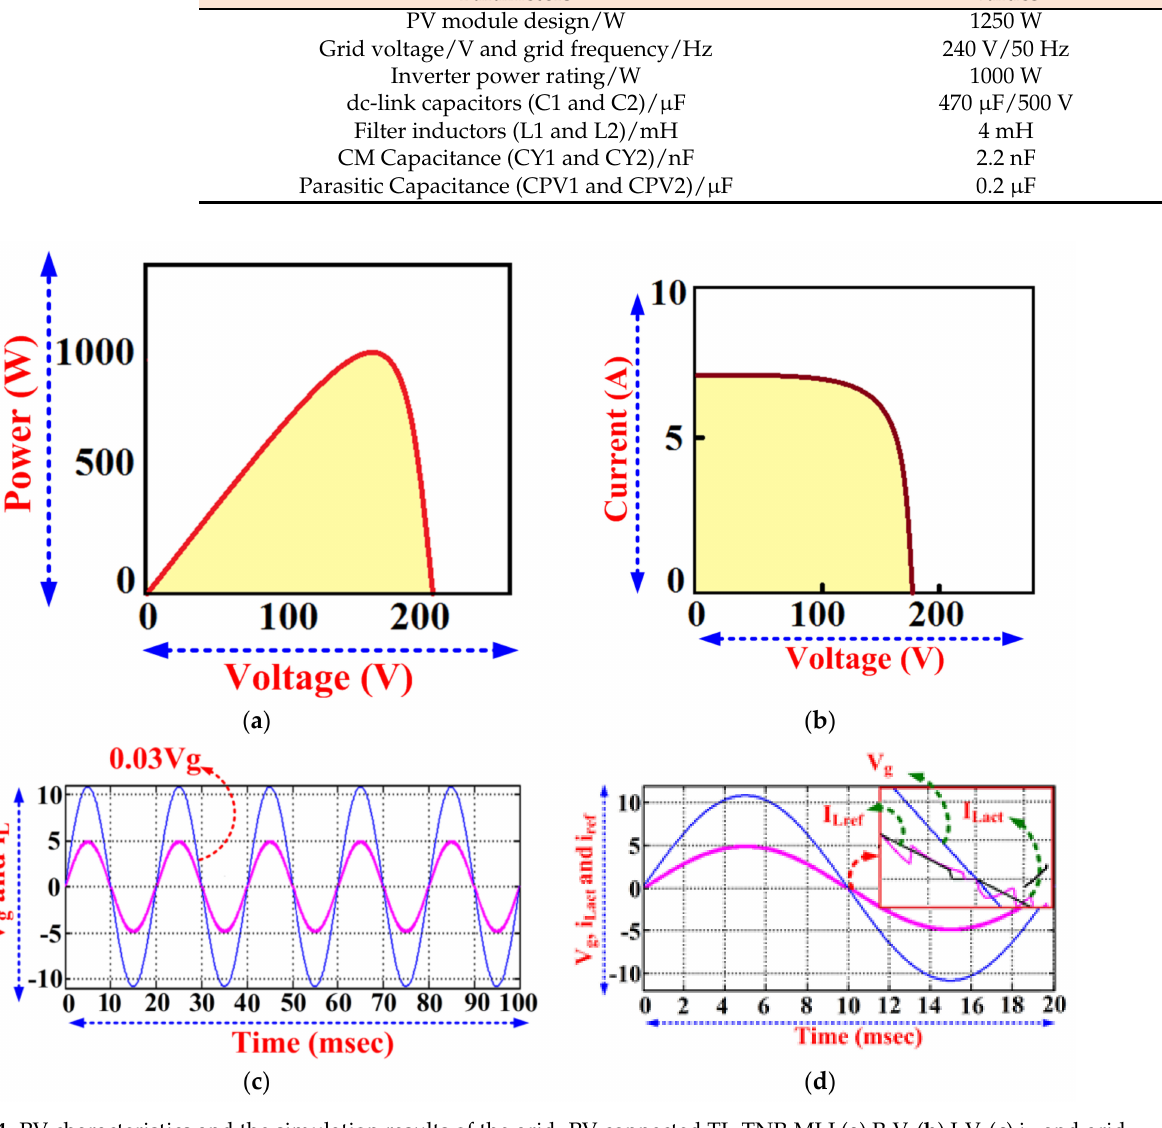
Figure 4. PV characteristics and the simulation results of the grid -PV connected TL-TNP-MLI ( a ) P-V, ( b ) I-V, ( c ) i L and grid voltage V g , ( d ) zoomed view on i L verse V g